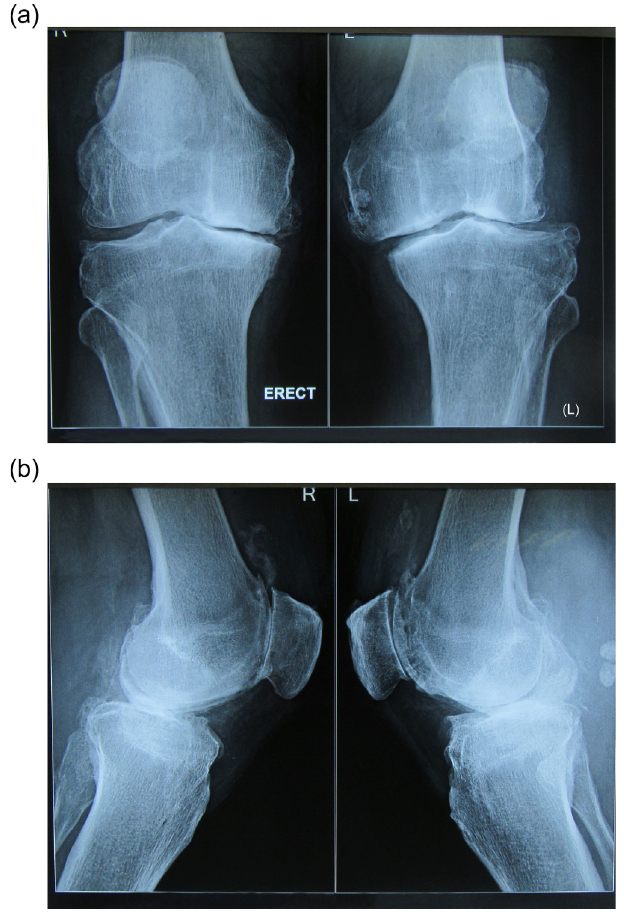
Figure 4. (a) Anteroposterior (AP) X-ray of the bilateral knee showing decrease in the joint space (left > right) with lateral tibial subluxation of the left knee. (b) Lateral radiograph of both the knee showing multiple osteophytes and degenerative changes in the patellofemoral